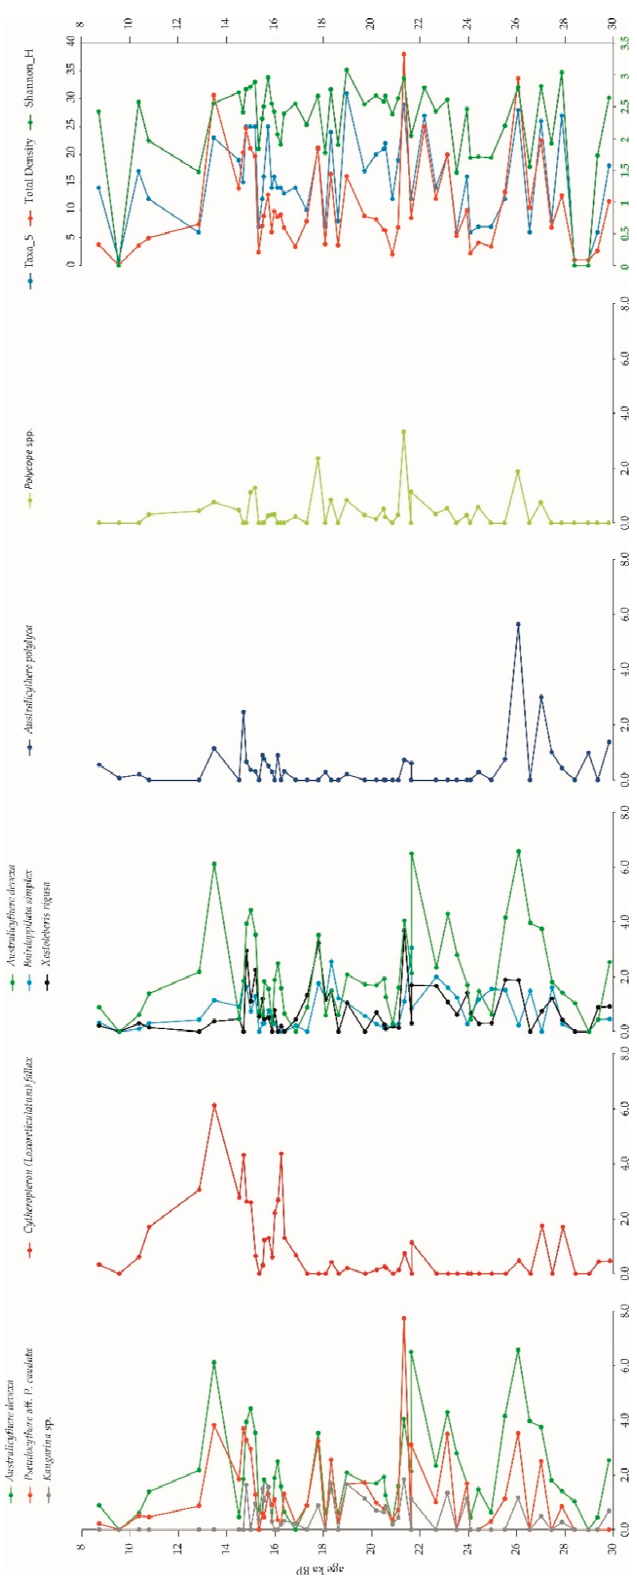
Figure 5. Main Ostracod species abundances ( > 50 µ m fraction) in number of specimens per gram of dry sediment in core ANTA91-09. Species Richness (S), Total Density (i.e., the number of individuals in each sample) (upper values axis—shown in black), and the Shannon Diversity Index (lower values axes—shown in green) are also reported.